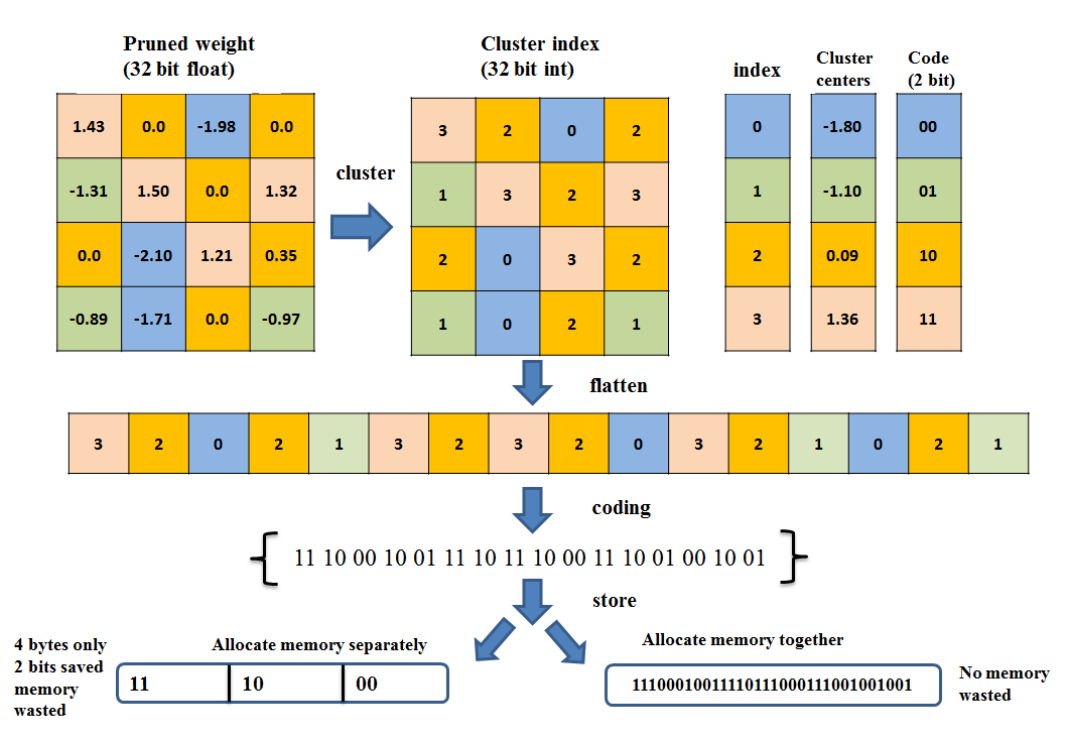
Figure 5. Weight sharing and quantization in pruned weight